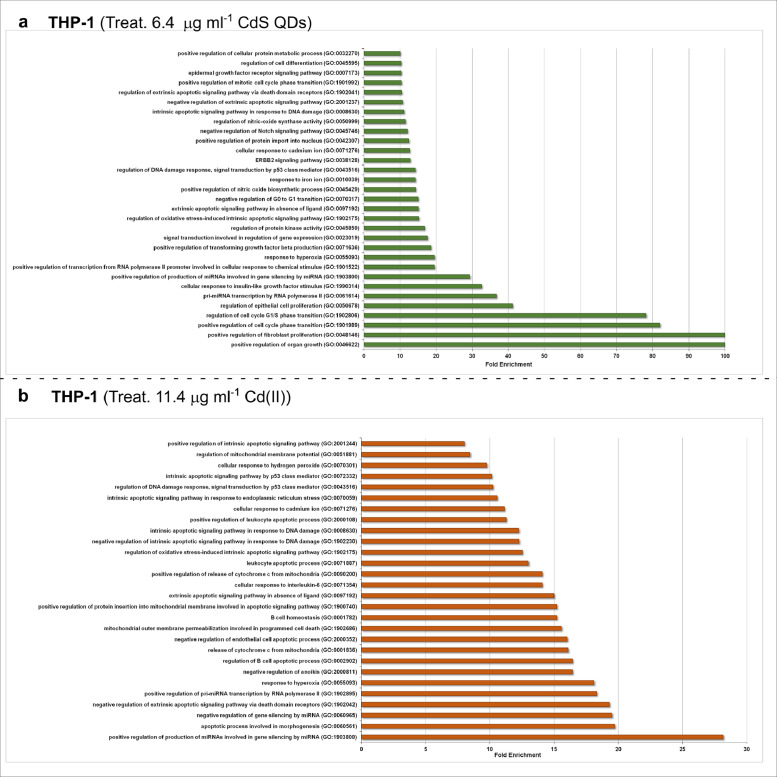
GO enrichment analysis of target genes of THP-1 miRNAs modulated by Cd stress.a, The gene targets in cells challenged with the low dose of Cd (5 µg ml−1) as 6.4 µg ml−1CdS QDs belonged to the GO categories: 'positive regulation of cell cycle phase transition', 'regulation of cell cycle G1/S phase transition' and 'positive regulation of transcription from RNA polymerase II promoter involved in cellular response' CdS QDs.b, The gene targets in cells challenged with Cd(II), equivalent to 5 µg ml−1 Cd, belonged to the GO categories: 'regulation of B cell apoptotic', 'release of cytochrome c from mitochondria', 'positive regulation of protein insertion into mitochondrial membrane involved in apoptotic signaling pathway' and 'leukocyte apoptotic process'. Note: GO enrichment analysis were performed using PANTHER software (p < 0.001).